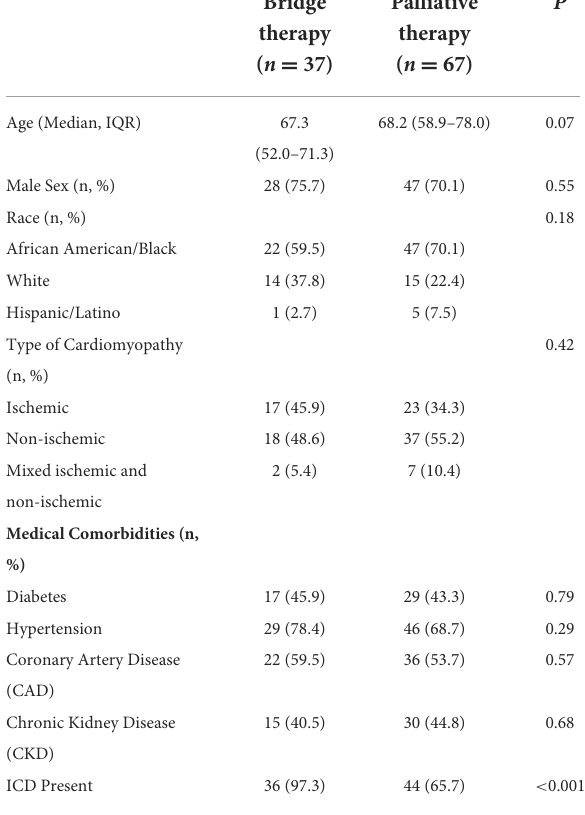
analyses. Statistical significance was determined at a 2-tailed P < 0.05.